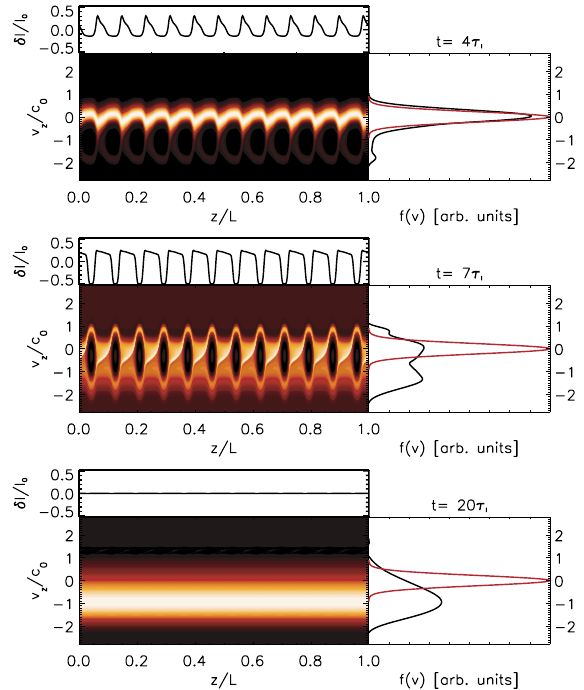
FIG. 7. (Color) Contour plots of the distribution function f (cid:2) z , y z (cid:3) together with the line density r L (cid:2) z (cid:3) and the velocity distribution f (cid:2) y z (cid:3) obtained from the Vlasov simulation for U sc (cid:2) 10 , V bb (cid:2) 1 , and n r (cid:2) 12